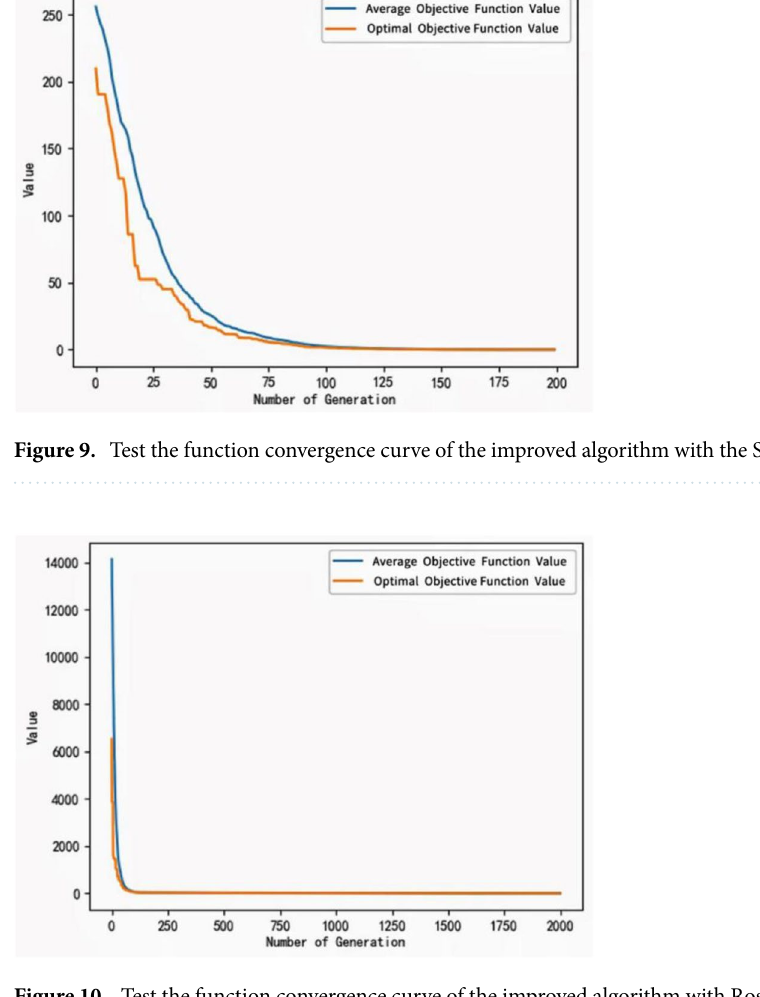
Figure 10. Test the function convergence curve of the improved algorithm with Rosenbrock test